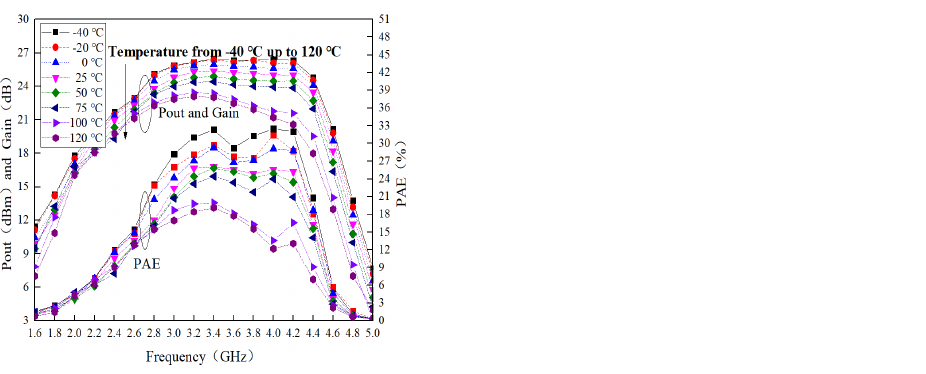
Figure 12. Measured curves of RF output characteristics with Pin of 0 dBm at different temperatures.